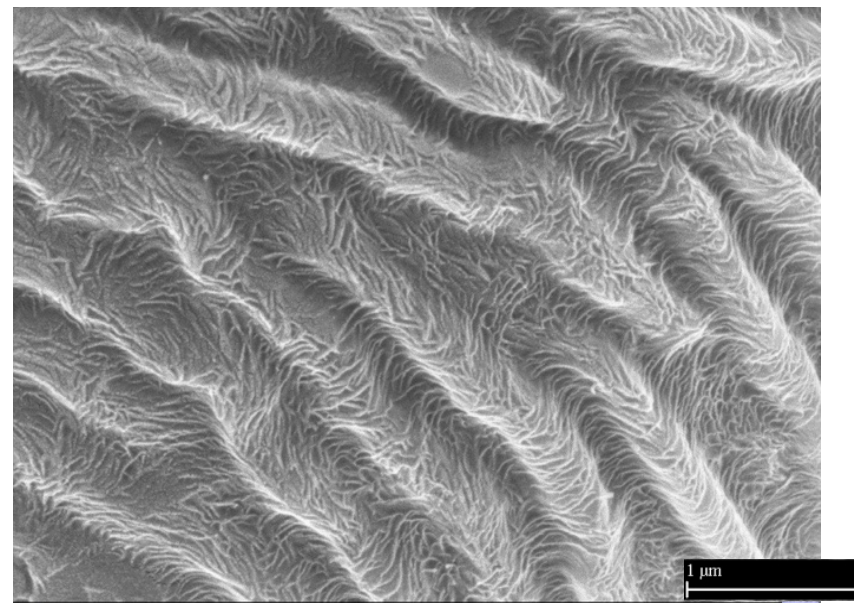
Figure 8. Polymer replica surface. Detailed microscopic image of the polymer replica surface made of a crystallizing polymer with visible nanostructure. Reprinted from ref.